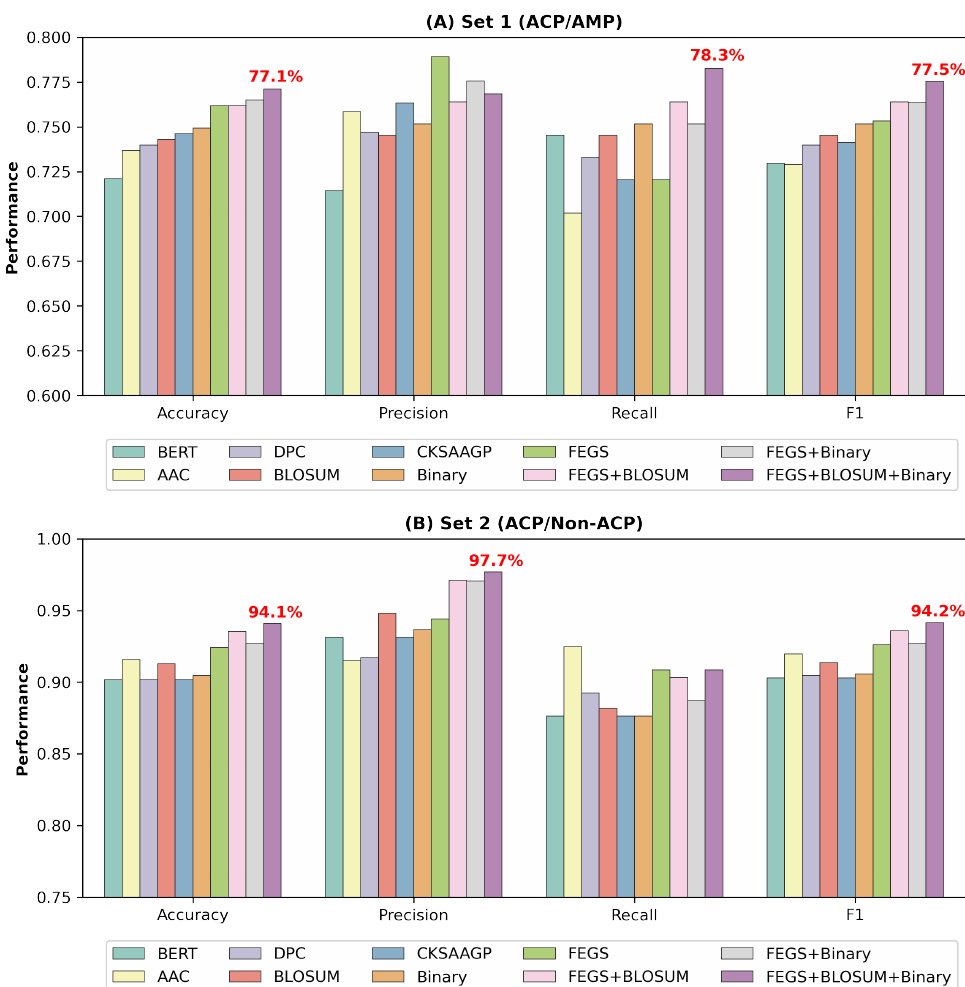
Figure 1. Performance comparison of different features on independent test sets of Set 1 and Set